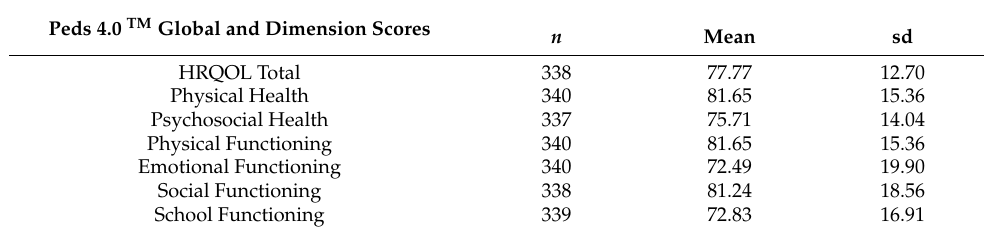
Table 7. Children’s health-related quality of life in primary school during the